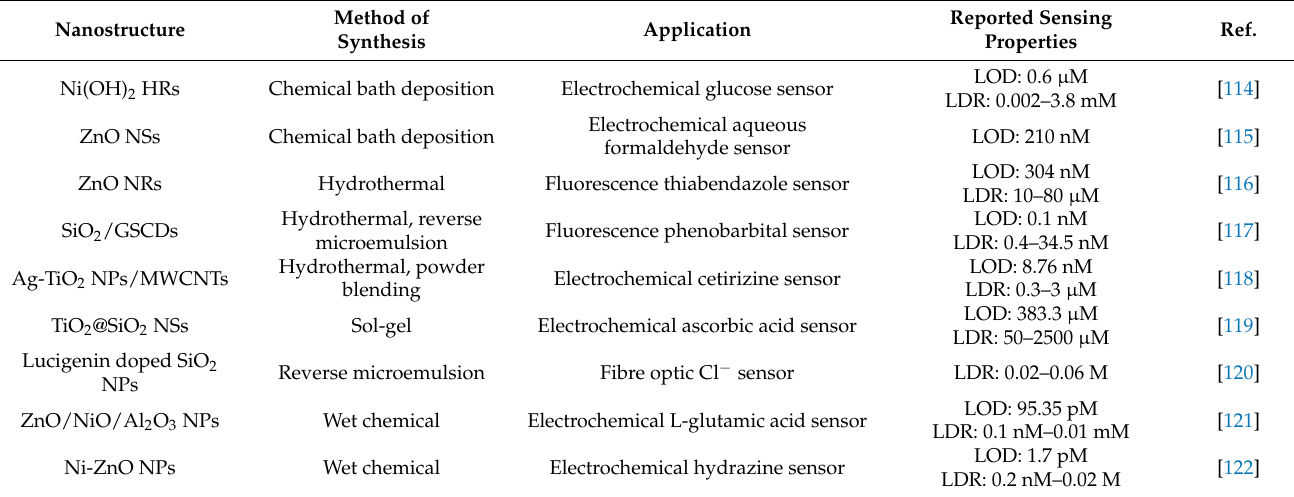
Table 2. Nanostructure formation methods, detected analyte, and reported chemical sensing